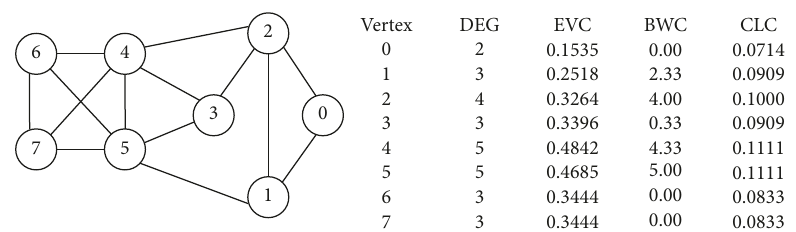
Figure 1: Example graph and the “raw” centrality values for the